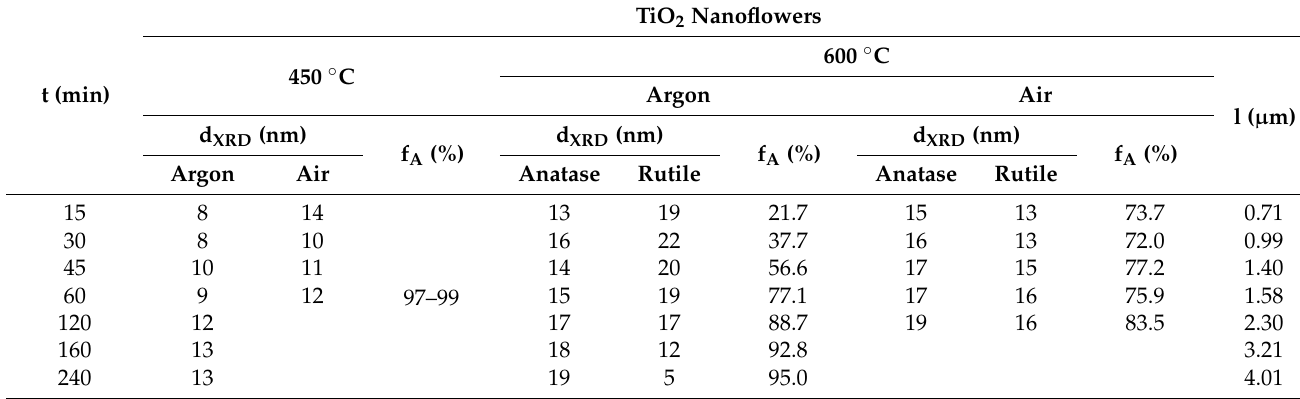
Table 2. Structural features of flower-like 3D